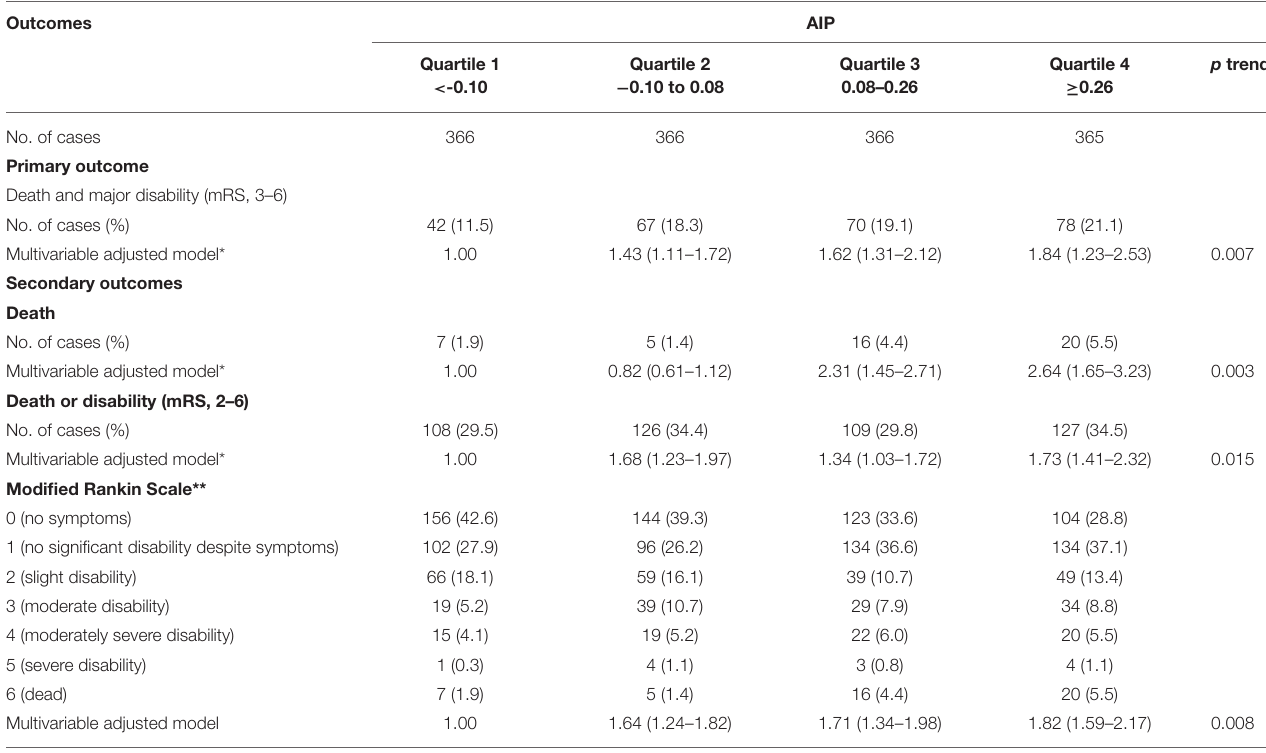
TABLE 2 | ORs (95% CI) for different outcomes associated with AIP after AIS. Outcomes